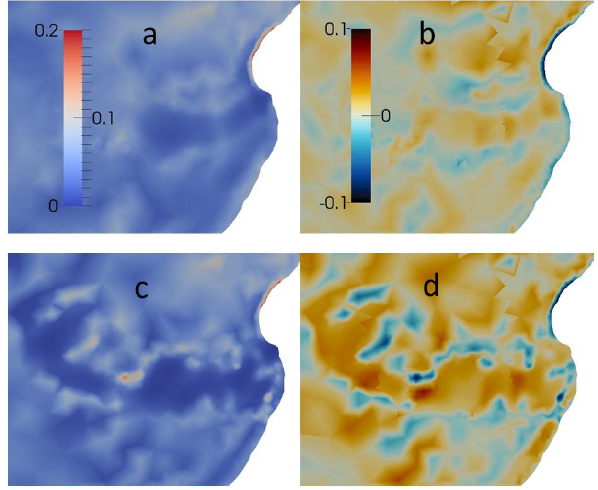
Figure 6. Basin 3 stress balance. Left: simulated basal shear stress ( τ b ) from the inverse modelling for (a) 1995 and (c) 2011. Right: Fig. 6. Basin 3 stress balance. At left: simulated basal shear stress gravitational driving stress (calculated from ice cap geometry) mi- ( τ b ) from the inverse modelling for (a) 1995 and (c) 2011. At right: nus basal shear stress for (b) 1995 and (d) 2011. Note that the zigzag gravitational driving stress (calculated from ice cap geometry) mi- discontinuities visible in the plots on the right are artefacts of the nus basal shear stress for (b) 1995 and (d) 2011. Note that the zig parallel domain decomposition in a post-processing step and do not Fig. 6. Basin 3 stress balance. At left: simulated basal shear stress zag discontinuities visible in the plots at right are artefacts of the significantly affect the stress patterns. Units are MPa. ( τ b ) from the inverse modelling for (a) 1995 and (c) 2011. At right: parallel domain decomposition in a post processing step and do not gravitational driving stress (calculated from ice cap geometry) mi- significantly affect the stress patterns. Units are MPa. nus basal shear stress for (b) 1995 and (d) 2011. Note that the zig zag discontinuities visible in the plots at right are artefacts of the parallel domain decomposition in a post processing step and do not significantly affect the stress patterns. Units are MPa. Figure 7. Change in free surface (in m) over 100 model years us- ing the 1995-derived basal drag field (simulation T95, left) and the 2011-derived basal drag field (simulation T11, right). Velocity con- tours (in ma − 1 ) are overlain to indicate regions of fast flow.